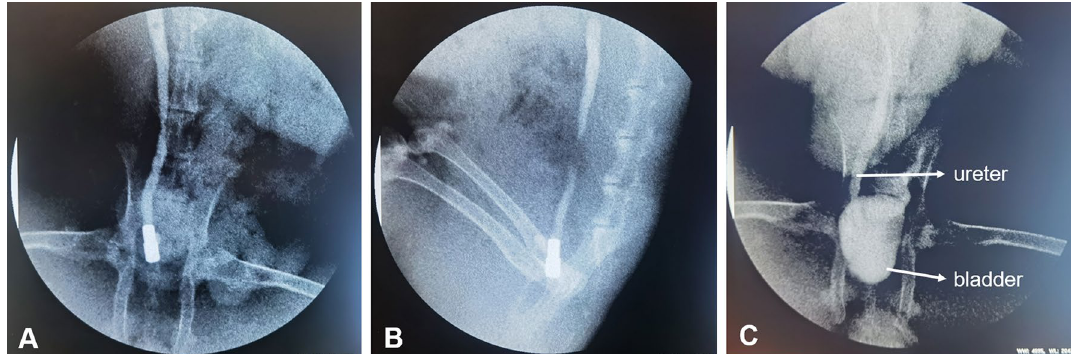
Figure 4. Confirmation of the position of the two magnets by ureterography. ( A ) Magnet location is shown on an abdominal radiograph; ( B ) Magnet location is shown on a lateral abdominal radiograph; ( C ) Right ureterography showing anastomotic